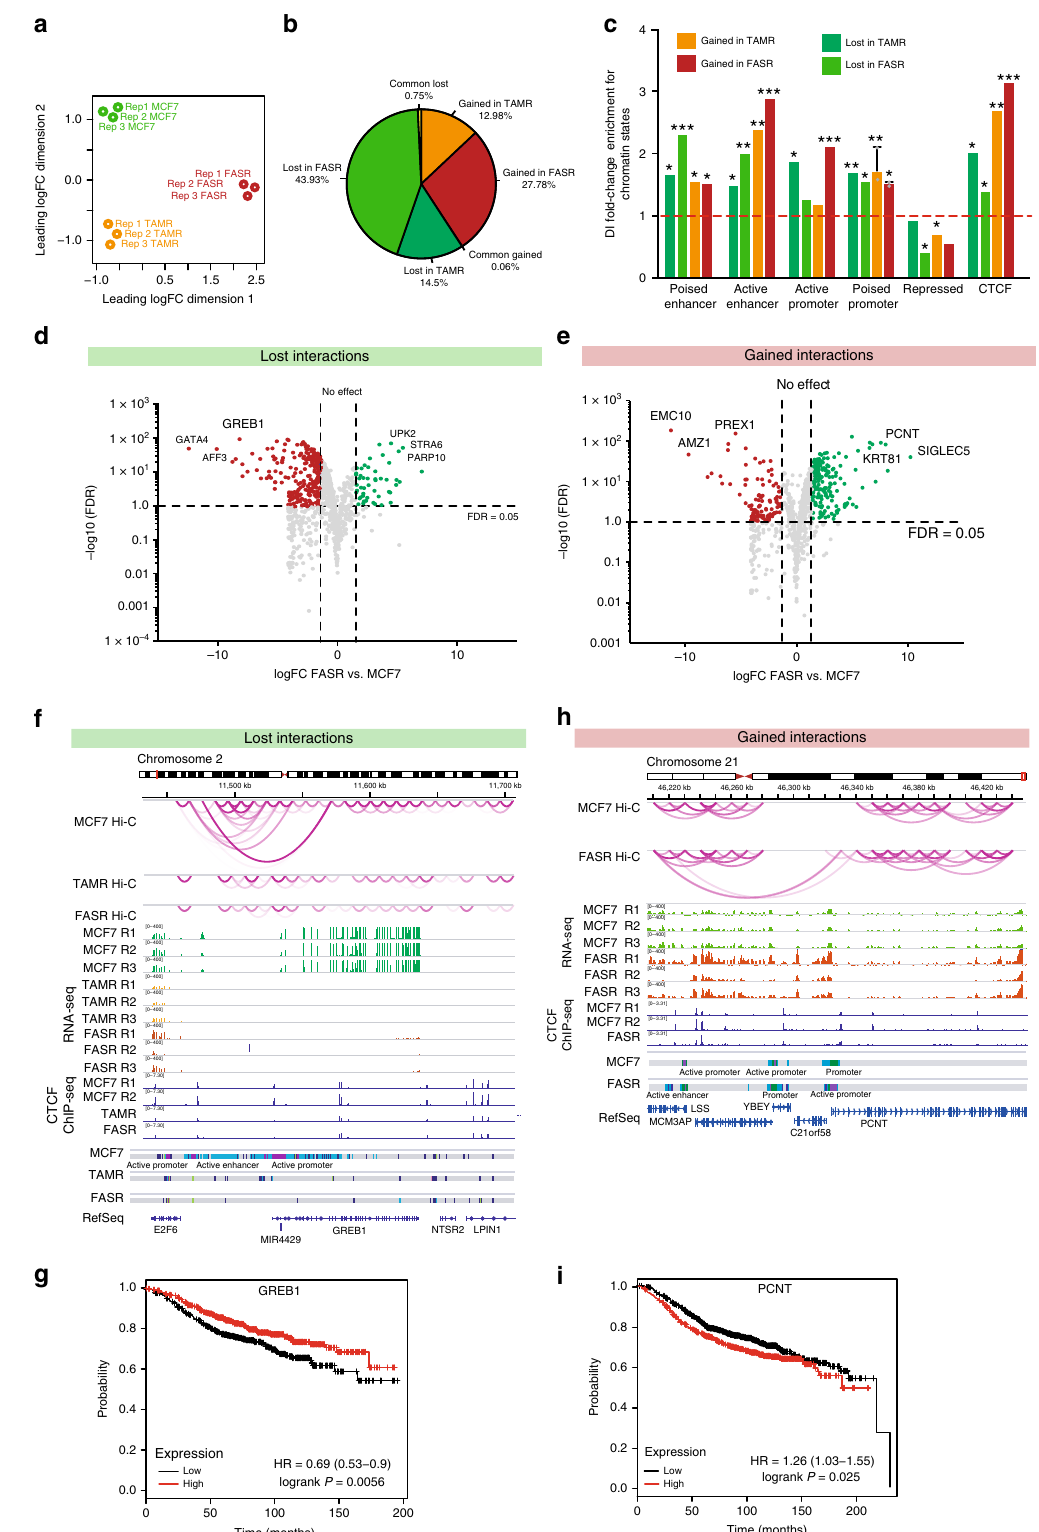
Figure 1f shows a representative example of differential interaction that is lost in both TAMR and FASR cells as compared to MCF7 cells. In MCF7 cells, the active promoter of the GREB1 gene is connected via strong long-range interactions with a putative distal active enhancer and the GREB1 gene is strongly expressed. In TAMRs and FASRs these distal